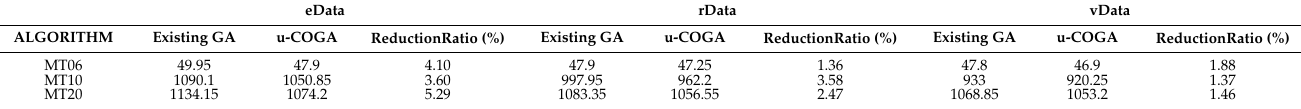
Table 10. Comparison of the best makespan obtained by the existing GAs and u-COGAs. eData rData vData